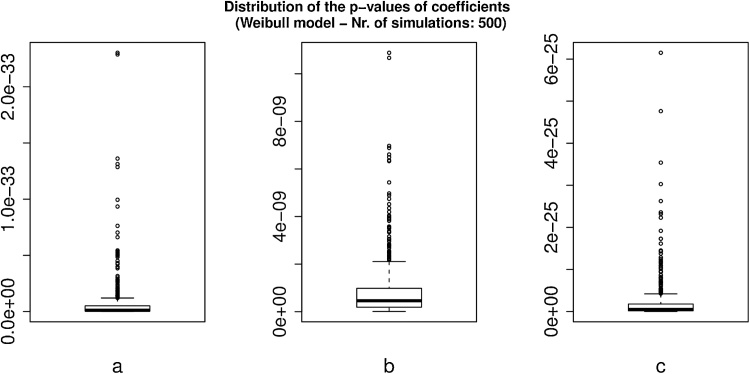
Boxplots of the distribution of the p-values for Weibull fit parameters a, b, and c in 500 simulations.